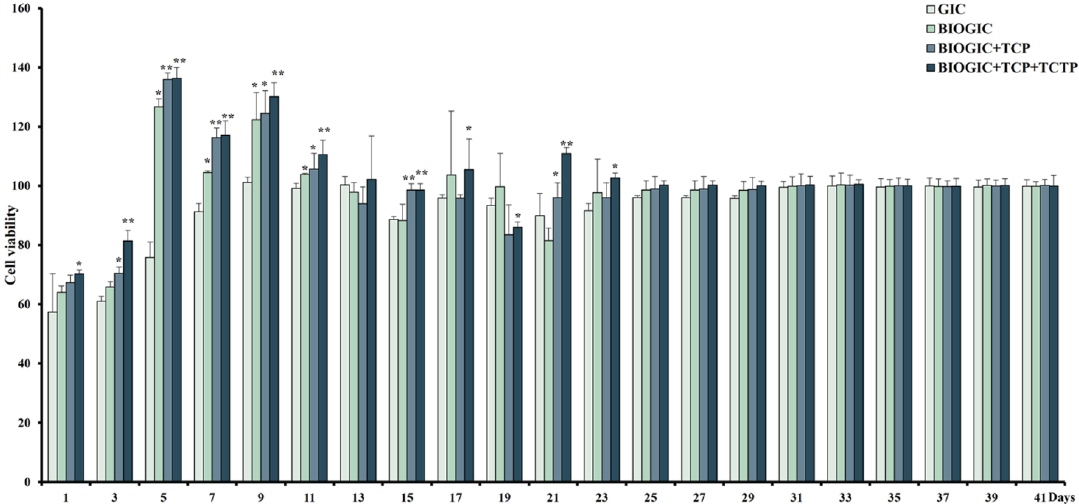
Figure 7. Long-term in vitro effect of different GICs on hDPSC viability. Results of MTT assay of cells cultured with different groups of GICs for 24 h to 41 days using transwell system. Data are represented as mean ± SD of cell populations. Value significant difference at * p < 0.05 and ** p < 0.01 compared to the GIC group ( n = 6 in each group).